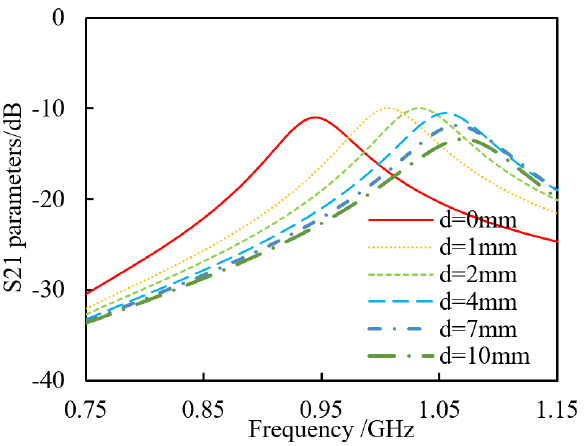
Figure 8. The simulated S 21 parameters with different distances from film.